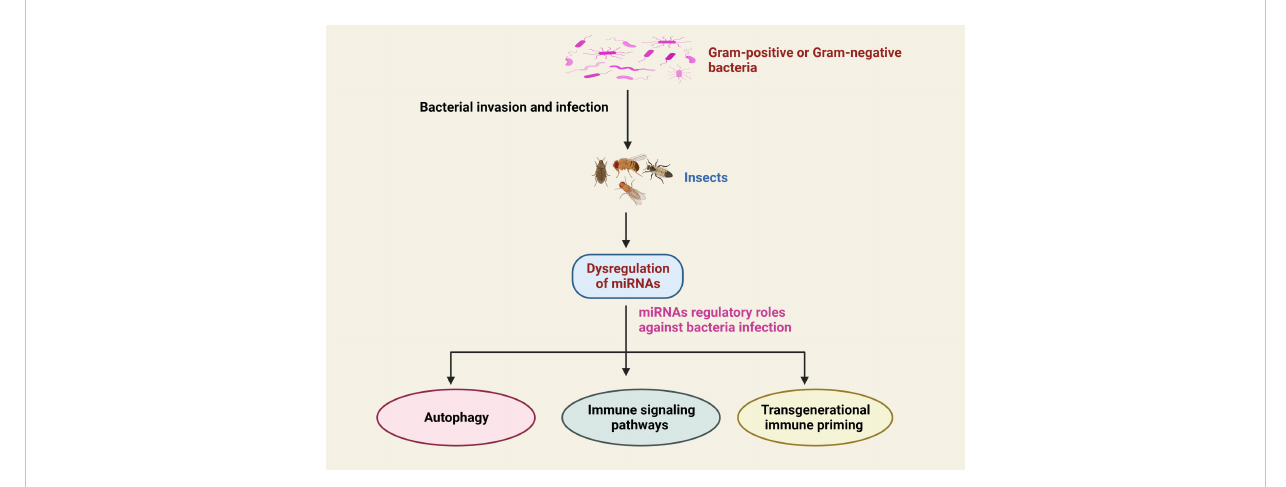
FIGURE 3 Schematic representation of the dysregulation of insect miRNAs in response to infection with Gram-positive or Gram-negative bacterial infection and their critical regulatory functions in the prevention of bacterial infection.